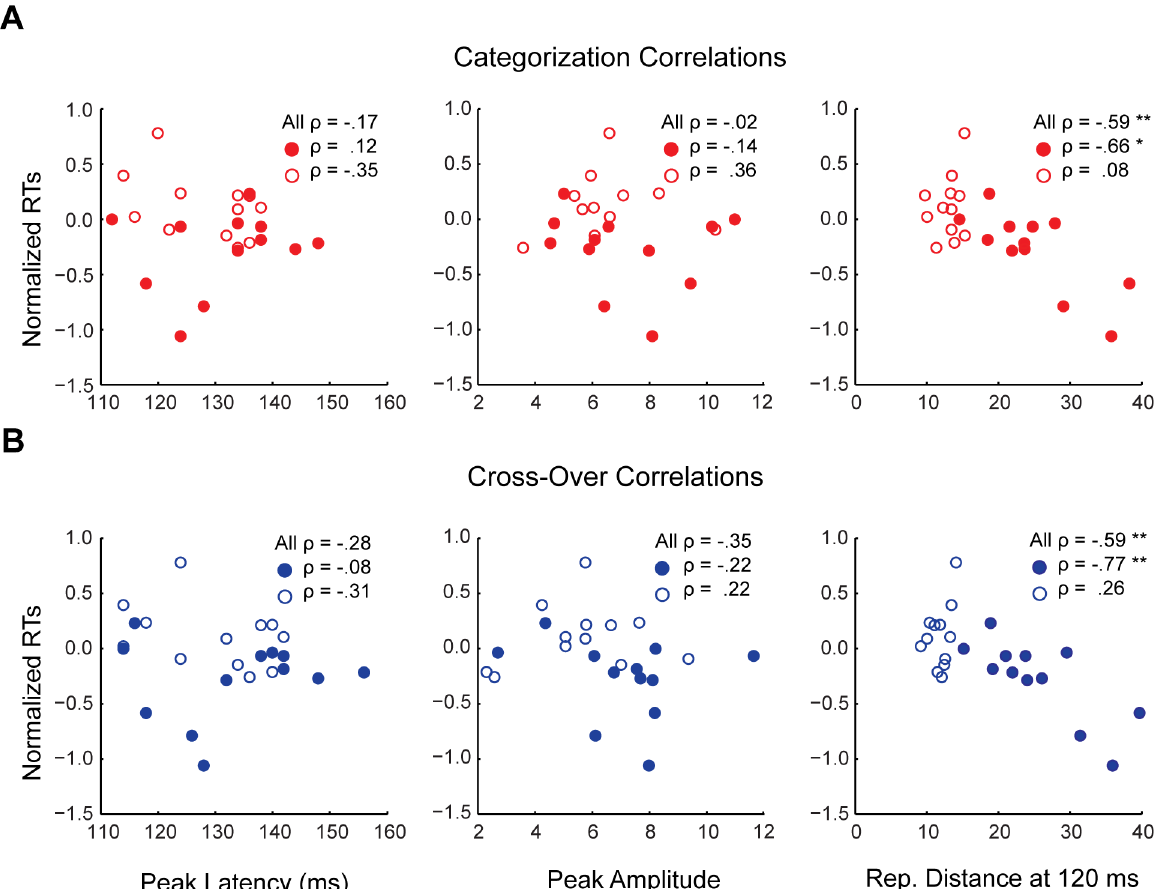
Fig 8. Correlations between sensory peak latencies and amplitudes and categorization task RTs. Scatter plots for the rank-order (A) categorization and (B) cross-over correlations (Spearman ’ s ρ ) between peak latency and peak amplitude and median normalized RTs for the categorization task. (A) Red circles indicate animate exemplar data points, while red rings indicate inanimate data points. (B) Blue circles indicate animate exemplar data points, while blue rings indicate inanimate data points. Peak amplitude scale is in units of 10 − 14 T. For comparison also plotted are the correlations between representational distance and RTs at 120 ms. Asterisks indicate significant correlations ( * = p < .01; ** = p < .001).